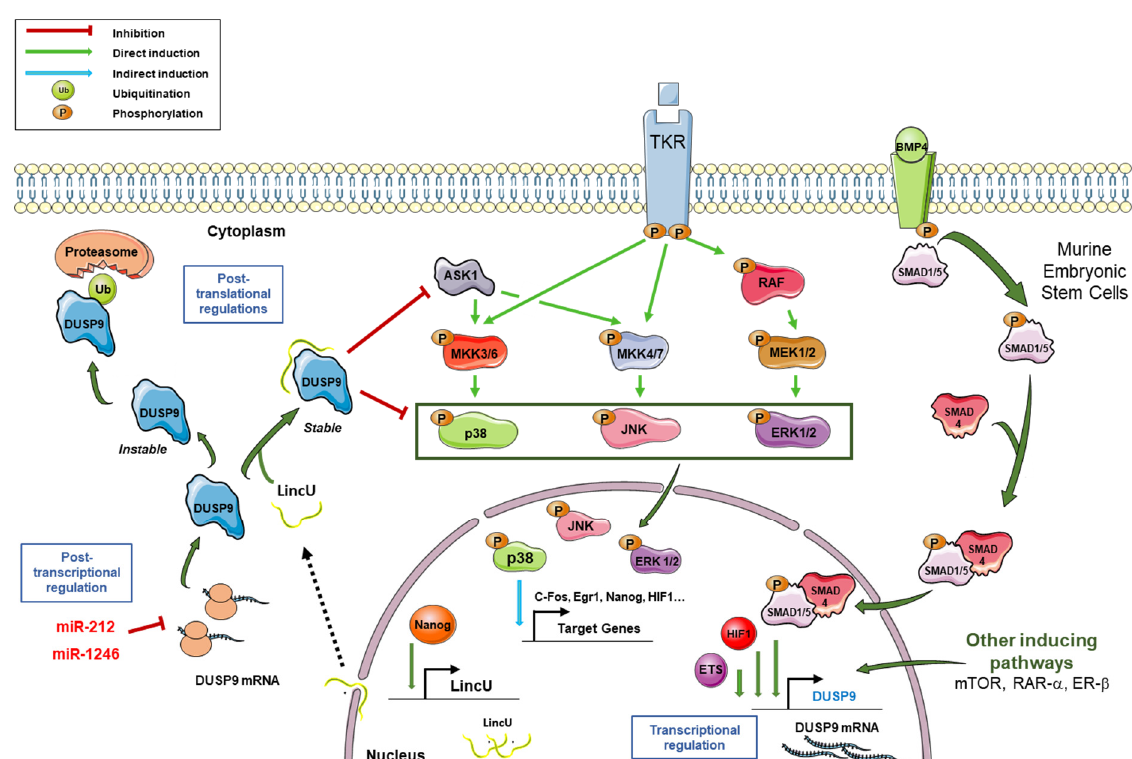
Figure 2. Regulation of DUSP9 expression and connection with MAPK pathways. Following the activation of tyrosine kinase receptors (TKR), MAPK pathways are activated through the successive phosphorylations of MAPKKKs (among which ASK1), MAPKKs MKK3/6, MKK4/7 and MEK1/2, and MAPKs p38, JNK and ERK. Phosphorylated MAPKs translocate to the nucleus and induce expression of the downstream targets c-FOS , ERG1 , NANOG and HIF1 , among others. In murine embryonic stem cells, the binding of BMP4 on its receptor induces the phosphorylation of Smad1/5, which then associates with Smad4. The Smad1/5–Smad4 complex translocates to the nucleus, binds the DUSP9 promoter and induces its transcriptional expression. Transcription factors HIF1- α and ETS can also induce DUSP9 expression. Besides the BMP signal, mTOR, RAR- α and ER β pathways can also potentiate the transcription of the DUSP9 gene. Following NANOG binding on LINCU promoter, the long non-coding RNA LincU is transcribed and exported in the cytoplasm where it associates with DUSP9 and stabilizes it. Stable DUSP9 can dephosphorylate its substrates, including ERK1/2, p38, JNK and ASK1. In the absence of LincU RNA, DUSP9 protein is unstable and is polyubiquitinylated before its degradation by the proteasome. DUSP9 can also be post-transcriptionally regulated by miR-212 and miR-1246, which target the 3 ′ -untranslated region of its mRNA. In summary, DUSP9 expression is tightly regulated by transcriptional, post-transcriptional and post-translational mechanisms.